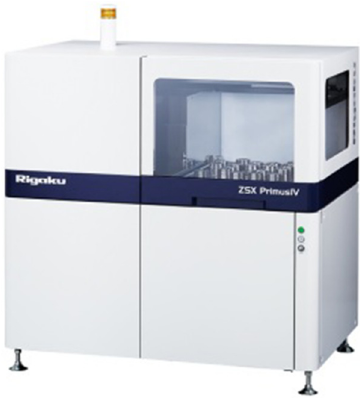
Fig. 20. X-ray fl uorescence